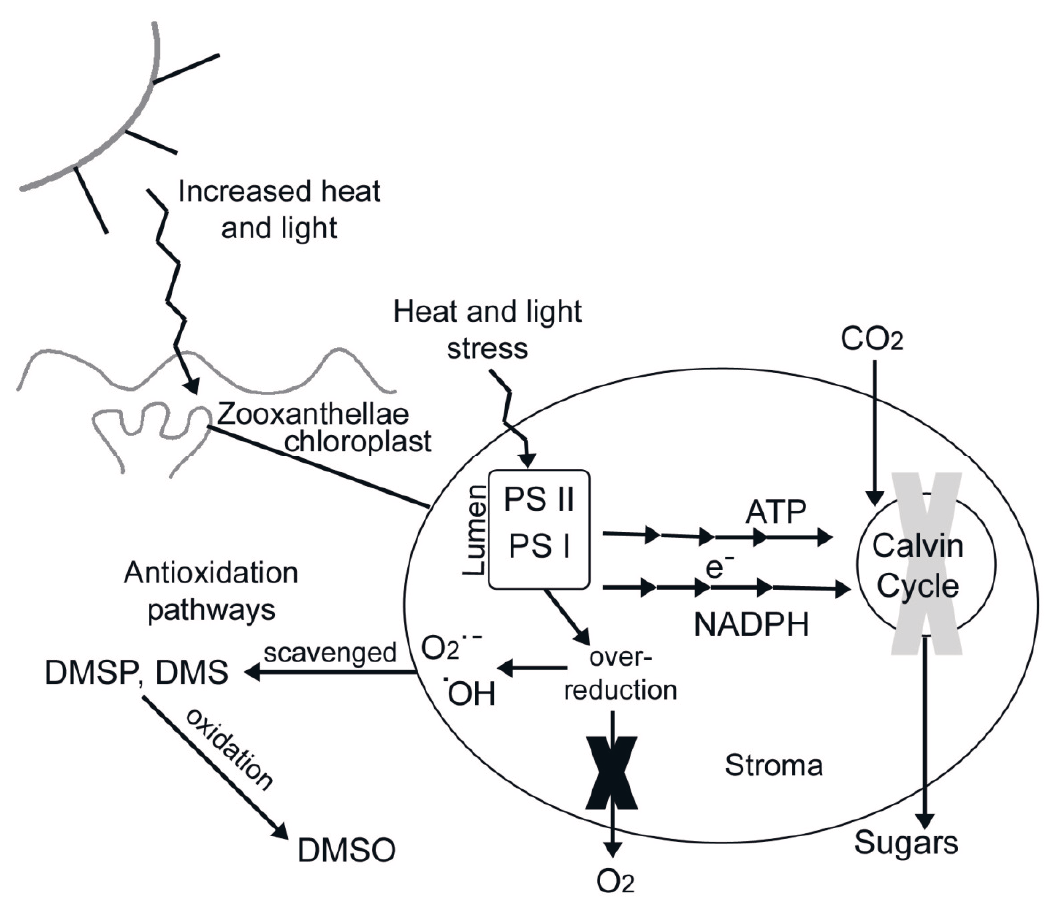
Figure 6. Conceptual diagram of oxidative stress processes and possible antioxidant roles of DMS, DMSP and DMSO in